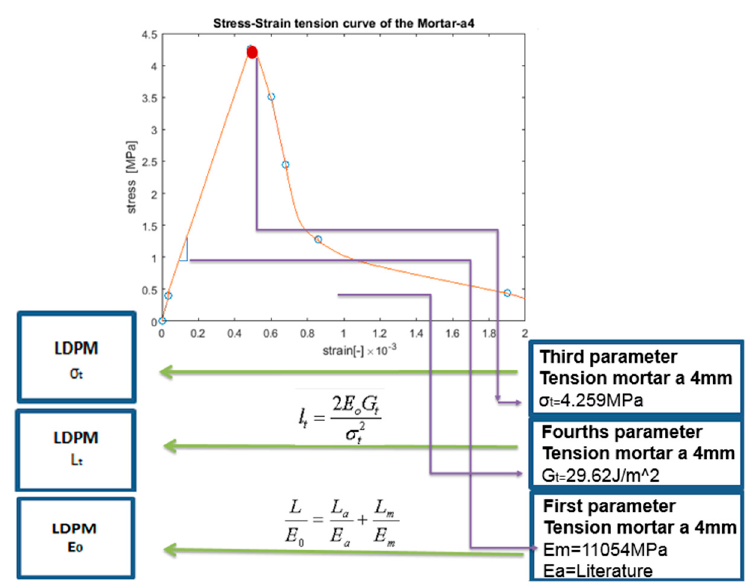
Figure 12. Mortar-a4 stress–strain curve.